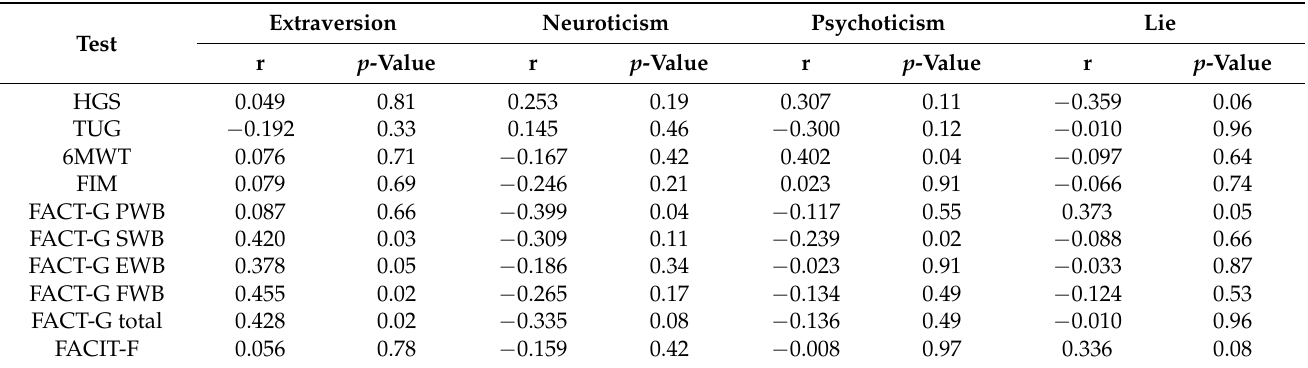
Table 3. Correlation between personality traits and the results of fitness tests, quality of life, and fatigue levels before